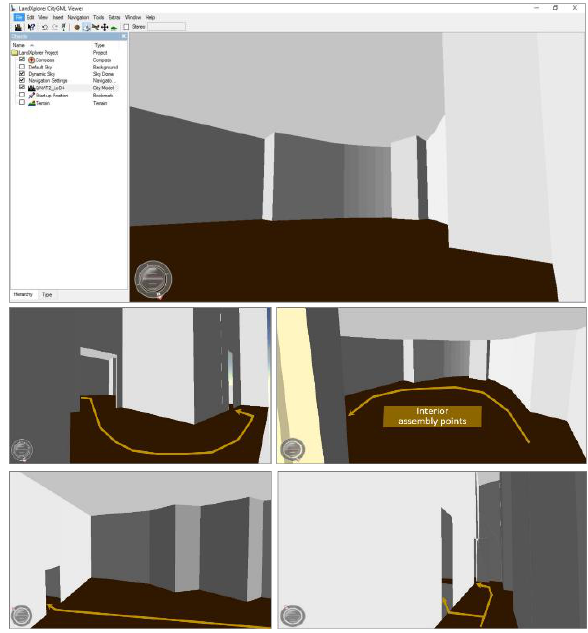
Figure 12. LoD4 model showing passages and interior